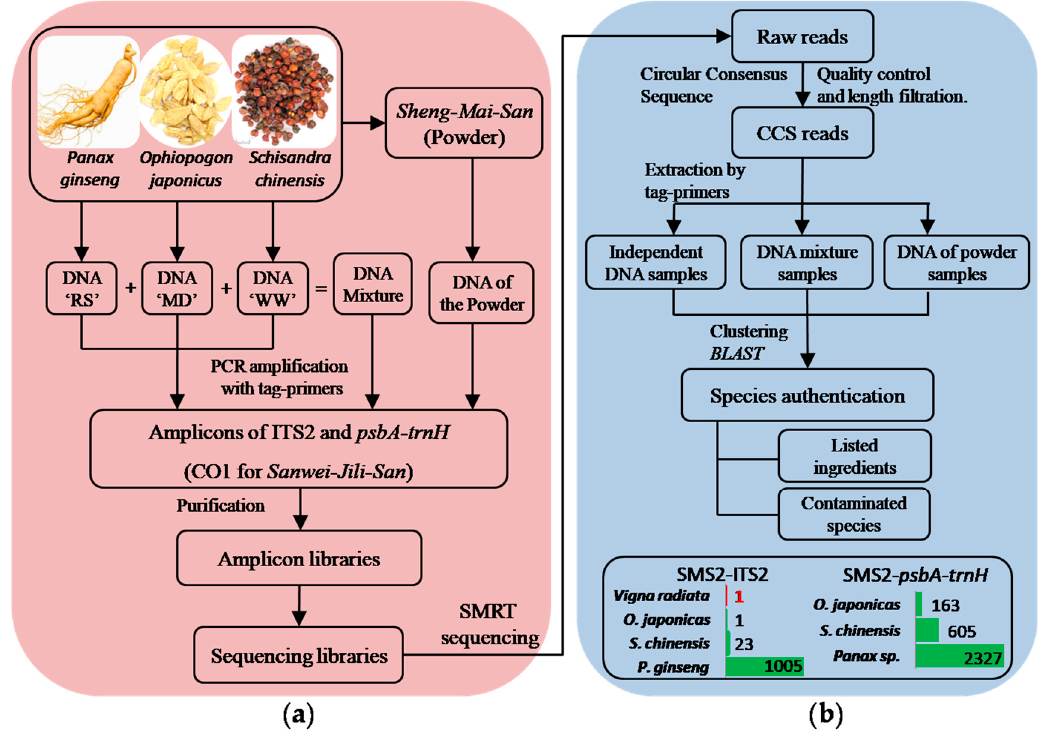
Figure 1. Pipeline of Full-length Multi-barcoding, analysis of SMS samples as an example. ( a ) sample preparation, ( b ) data analysis. (This figure was drawn by Peng Zhang).